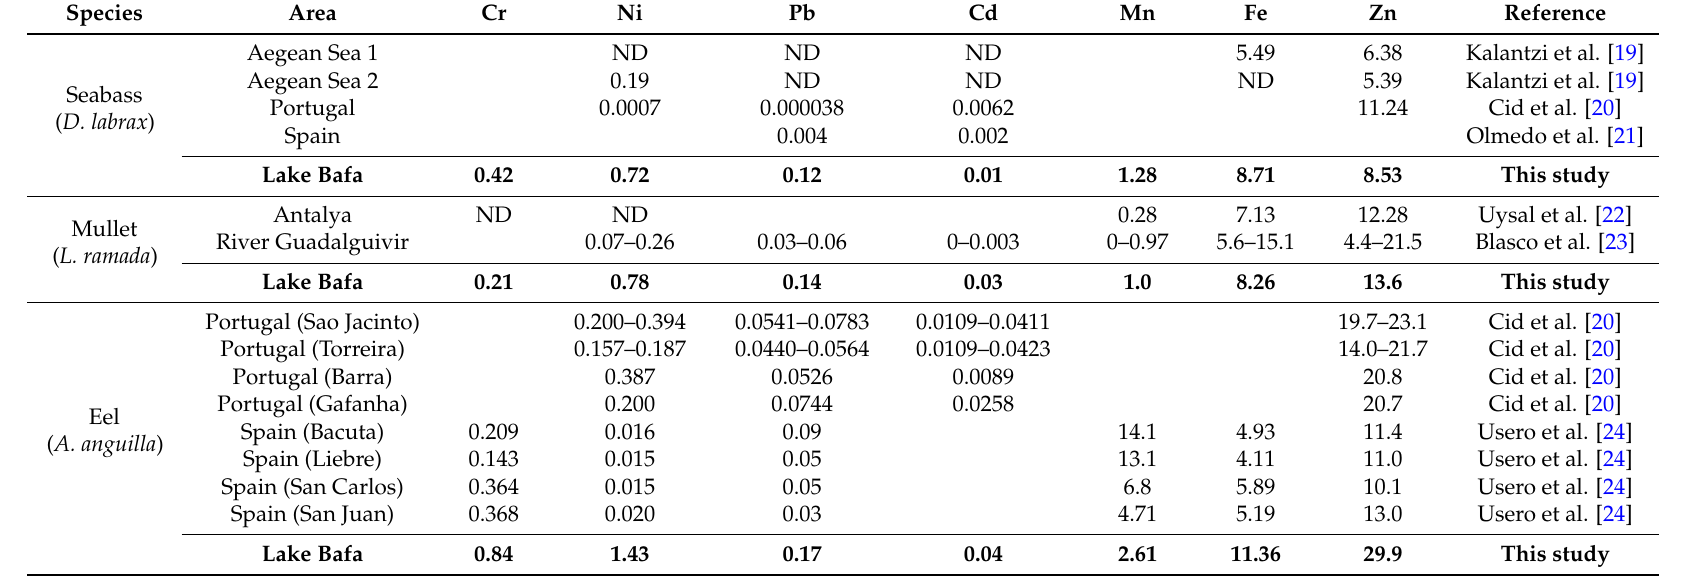
Table 1. Heavy metal concentrations (mg · kg − 1 ) in fish samples in the